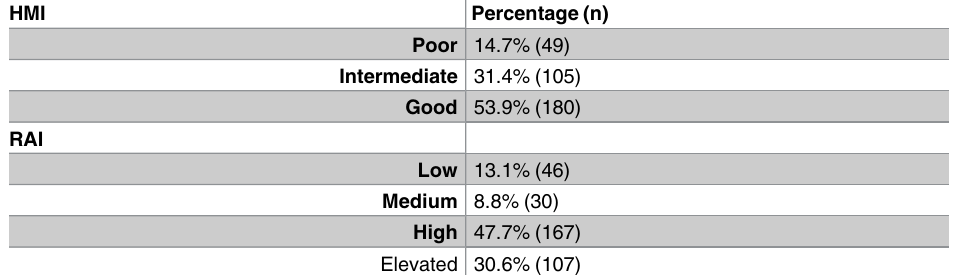
Table 3. Proportion of respondents by Household Materials Index (HMI) and Risk Activity Index (RAI)